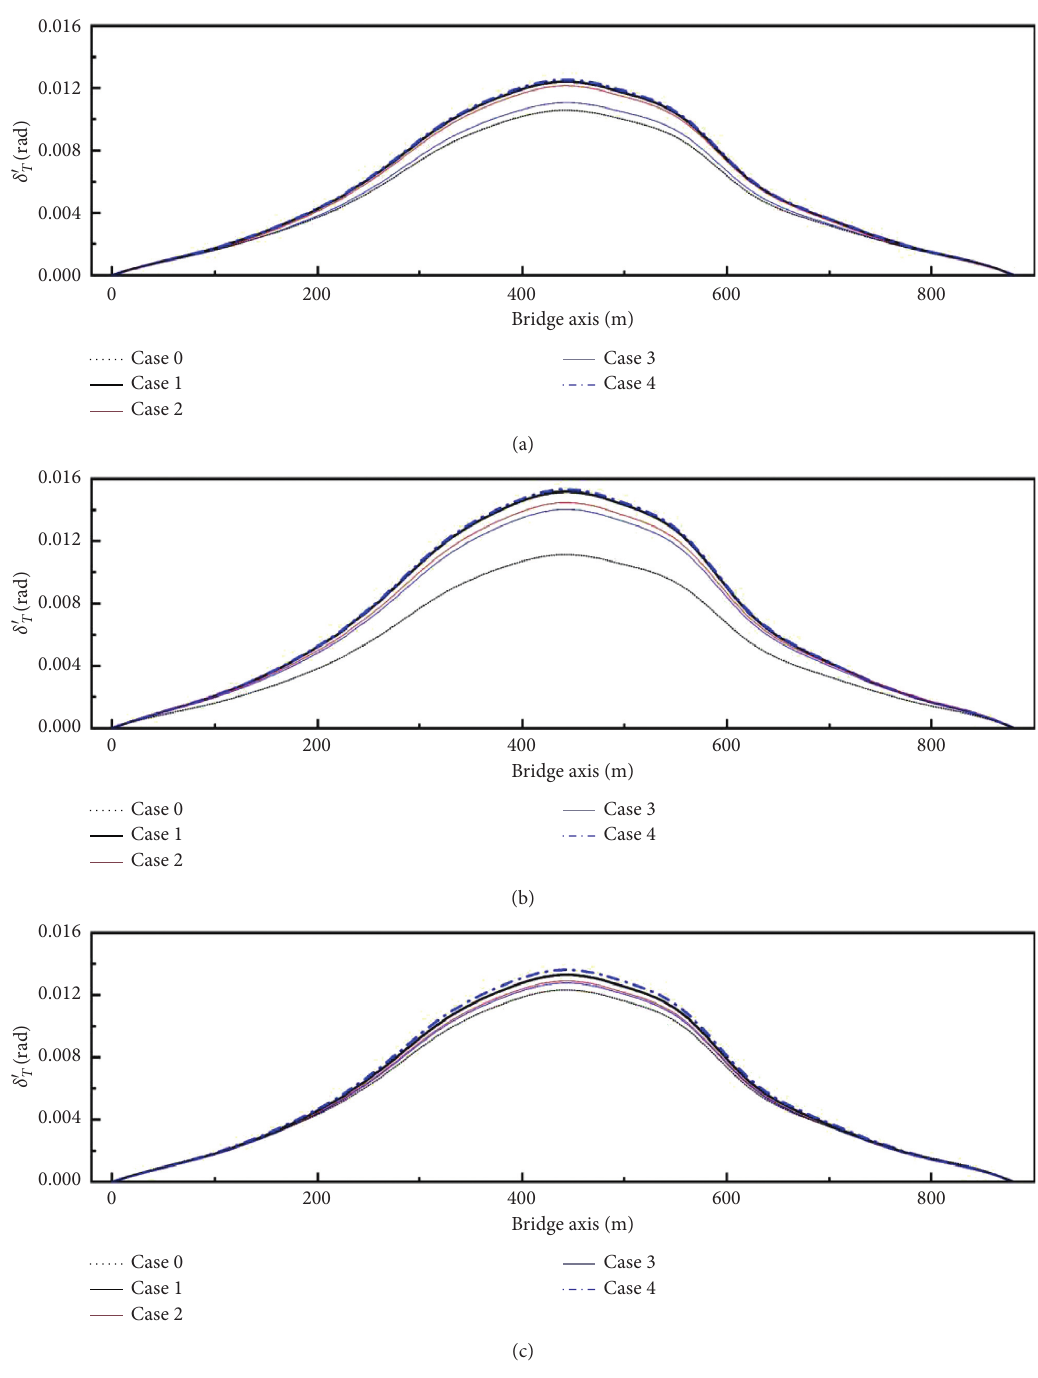
Figure 20: RMS torsional buffeting displacements of all the investigated cases at different AoAs: (a) AoA � 0 ° ; (b) AoA � +5 ° ; (c) AoA � − 5 °